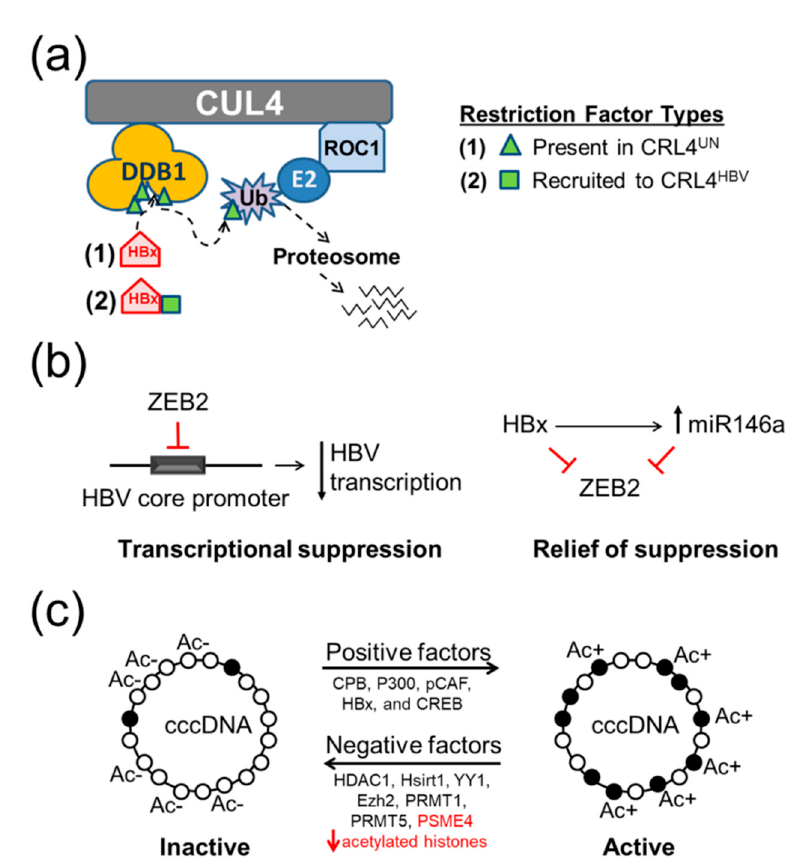
Figure 7. Proposed HBV restriction factor models: ( a ) Based on results of this study, this model proposes at least two categories of HBV restriction factors. Some HBV restriction factors are already present in the CRL4 UN (green triangles), while others are recruited to the CRL4 by HBx (green squares). ( b ) Proposed model to explain a role for ZEB2 as an HBV restriction factor. Left , ZEB2 is a DNA binding transcriptional repressor previously shown to bind to the HBV core promoter and significantly decrease HBV transcription [73]. Right , HBx relieves ZEB2-mediated transcriptional suppression by upregulating miR146a [107], which promotes HBV replication by targeting ZEB2 [106]. In the current study, we propose that HBx utilizes the CRL4 complex to target ZEB2 for degradation. ( c ) Proposed mechanism for restriction factor PSME4. Left , Transcriptionally inactive cccDNA has a preponderance of hypoacetylated histones (empty circles) and associates with specific factors ((histone deacetylases (HDACs), transcriptional repressors, and methyltransferases)] such as HDAC1 and Nicotinamide adenine dinucleotide (NAD)-dependent protein deacetylase sirtuin 1 (Hsirt1) [10], yin yang 1 (YY1) and enhancer of zeste homolog 2 (Ezh2) [111], protein arginine methyltransferase 1 (PRMT1) [109], and PRMT5 [110]. Right , Alternatively, transcriptionally active cccDNA contains a preponderance of hyperacetylated histones (filled circles) and associates with other factors including cyclic adenosine monophosphate (cAMP) responsive element binding protein 1 (CREB) [108], CREB binding protein (CBP), P300, P300 / CBP-associated factor (pCAF), PSME4 (red font, identified in this study) and HBx [10,11]. We propose that PSME4 is a viral restriction factor because of its ability to degrade acetylated histones [70,71], thereby helping to return cccDNA to an inactive state unless HBx is present to promote the degradation of PSME4.